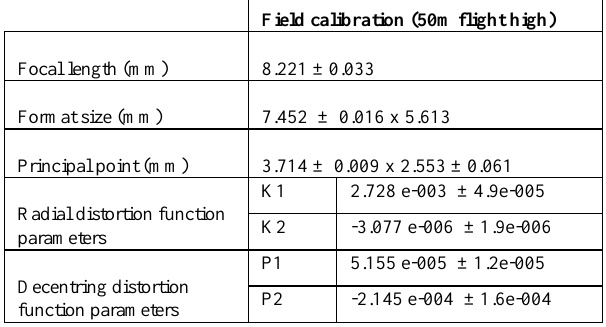
Table 2. Camera field calibration parameter values